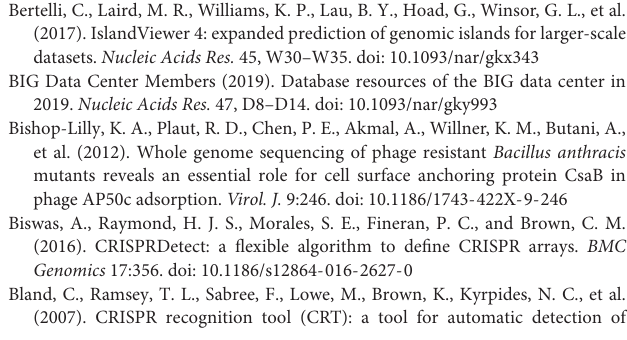
Supplementary Table 4 | Adjacent predicted proteins of CRISPR arrays detected. Supplementary Table 5 | Cas-related proteins identified with HMM against a prebuilt database with known Cas proteins and proteins with functions related with Cas proteins (.xls